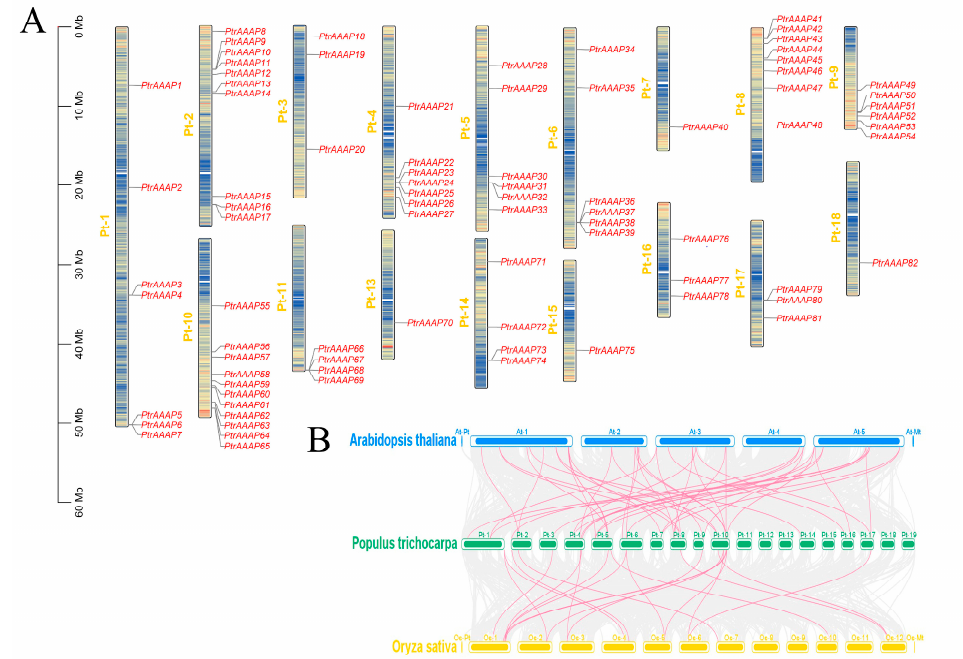
Figure 2. Chromosomal locations and collinearity analysis of the PtrAAAPs . ( A ) PtrAAAPs are marked on chromosomes; the scale bar on the left indicates the length of the chromosome Mb. ( B ) Collinearity relationship of AAAP genes among Populus trichocarpa (Pt), Arabidopsis thaliana (At), and Oryza sativa (Os). Identified collinear genes are linked by pink